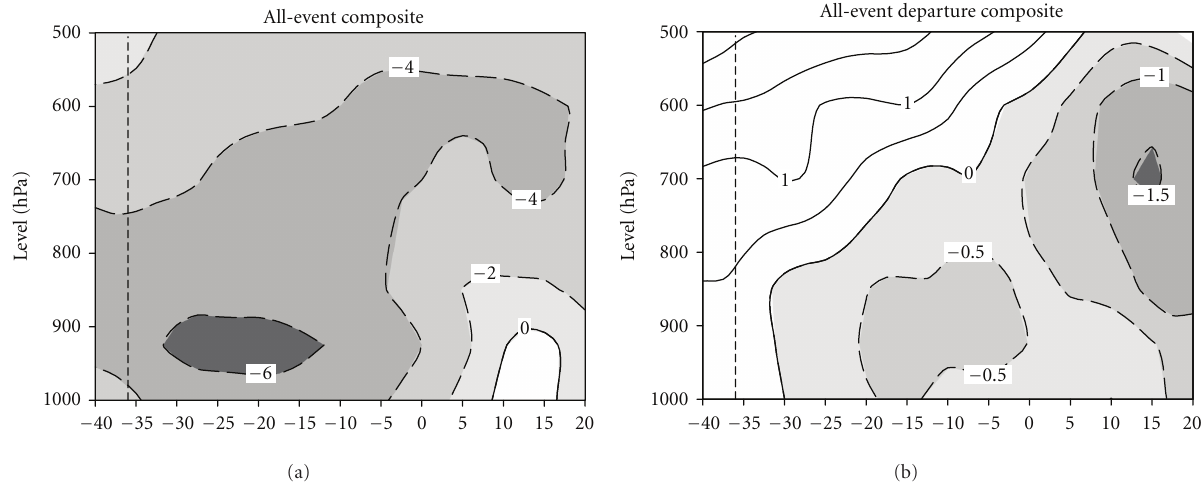
Figure 9: Altitude-longitude composite values (a) and composite anomalies (b) of zonal wind (m · s − 1 ) averaged over 2.5 ◦ S–12.5 ◦ S during the periods of the twelve selected events from the onset of EWs until the day (or first day) of strong rainfall anomaly episodes over ENEB. The vertical dashed line at 36 ◦ W schematizes the mean longitude of littoral ENEB. Easterlies (negative values) are shaded.